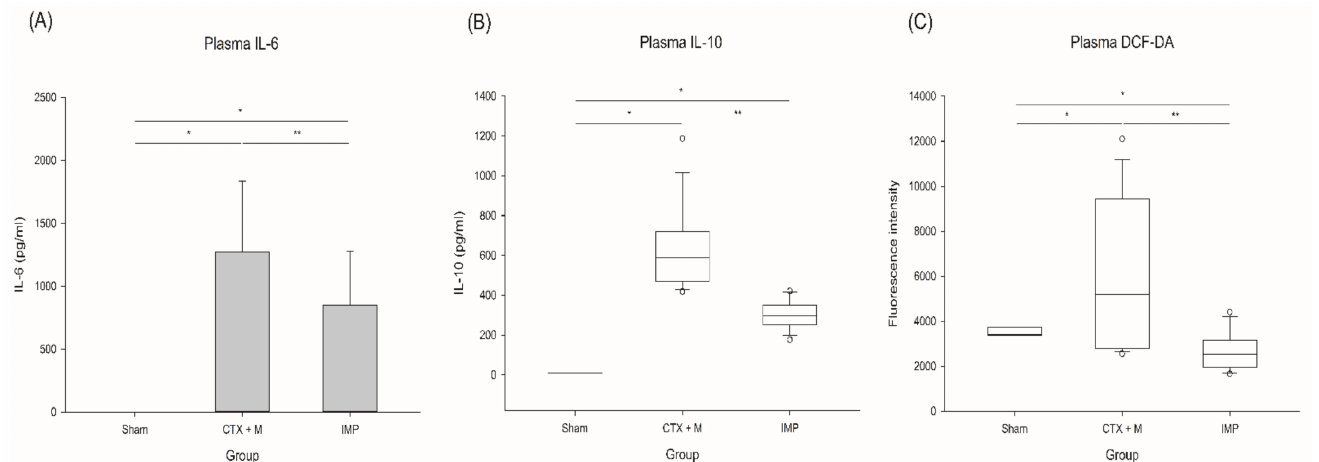
Figure 4. Inflammation and oxidative stress in severe IAI model. ( A ) IL-6, ( B ) IL-10, ( C ) ROS generation. n = 3 for sham, n = 14 for IMP and CTX + M, * p < 0.05 compared with sham, ** p compared with CTX + M model. IAI, intraabdominal infection; CTX + M, ceftriaxone with metronidazole; IMP, imipenem; ROS, reactive oxygen species; DCF-DA, 20,70- dichlorofluorescein diacetate.